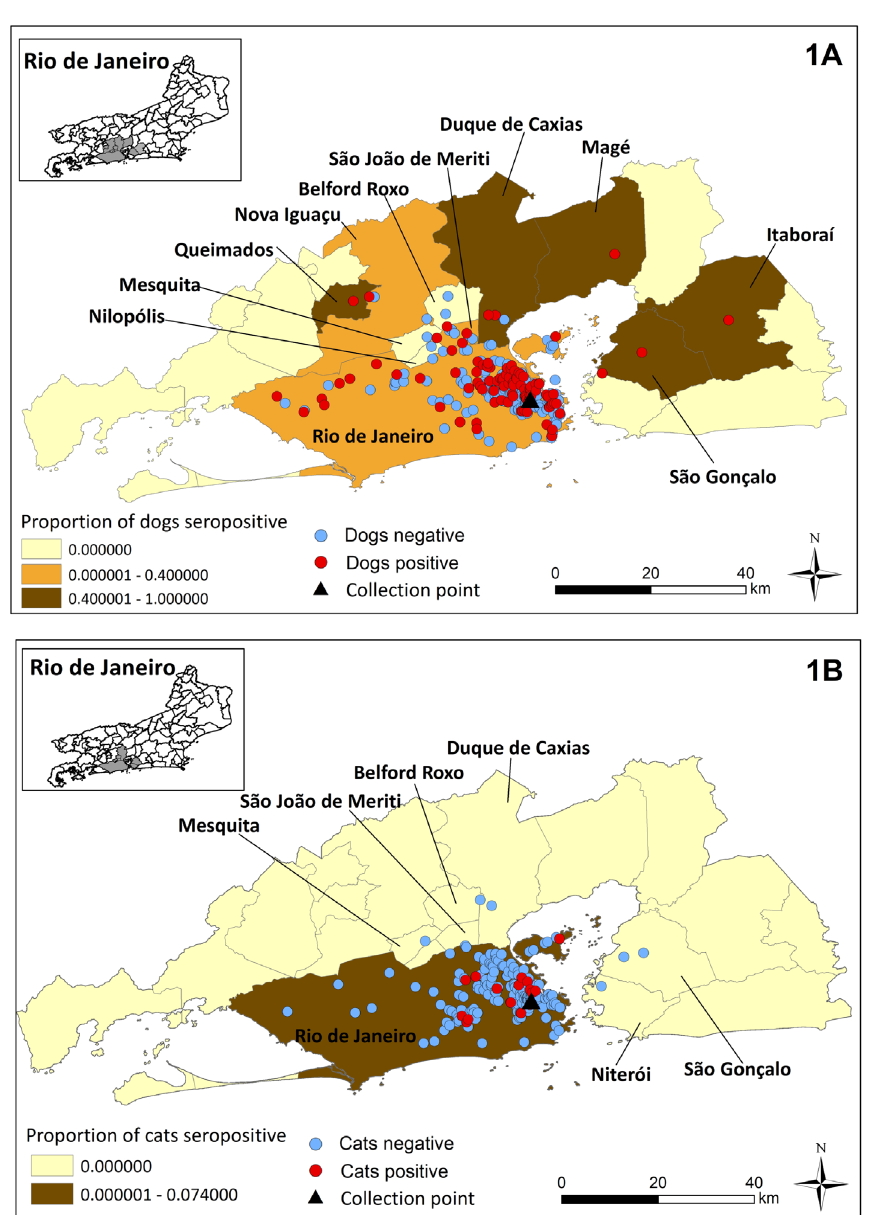
Figure 1. Spatial distribution of domiciled dogs (A) and cats (B) and proportion of T. gondii- seropositive animals by cities of the metropolitan region of Rio de Janeiro